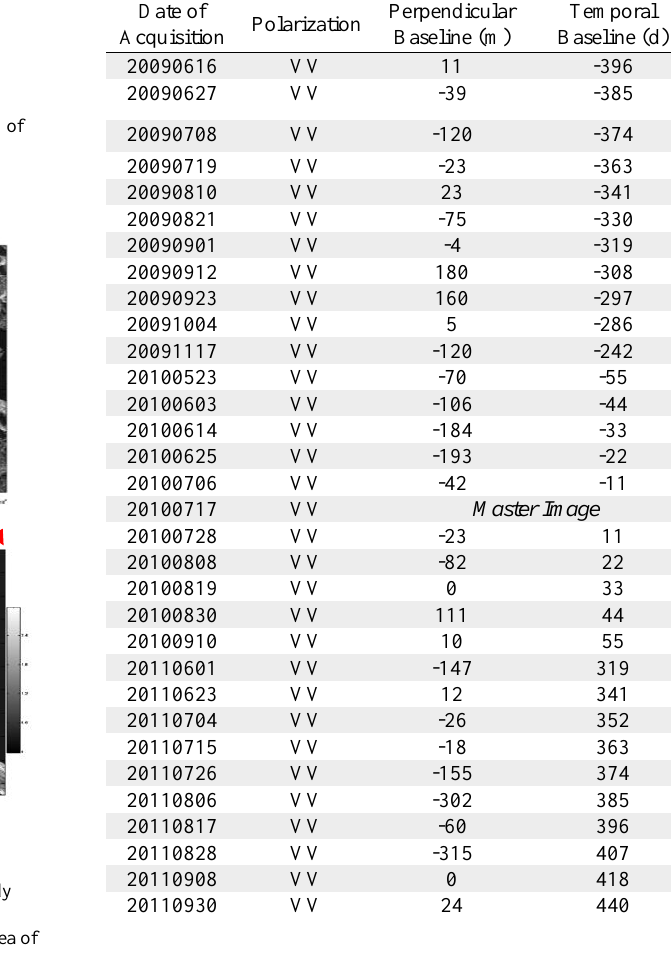
Table 1 Spatial & Temporal Baseline Distribution of dataset used with respect to the master